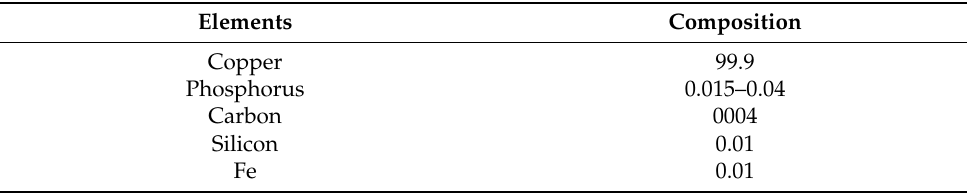
Table 1. Chemical composition of C12200 copper